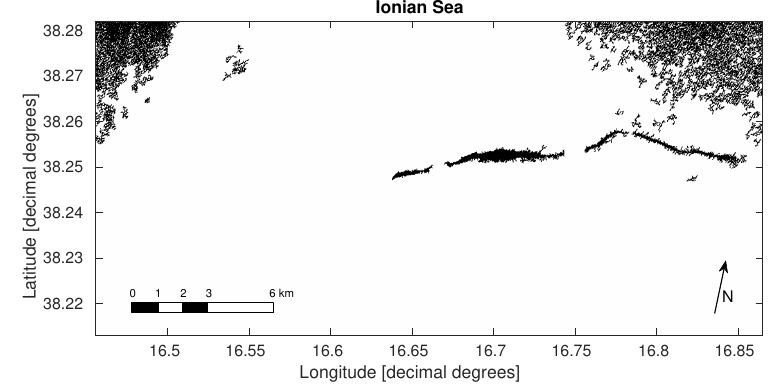
Figure 9. CSK StripMap HIMAGE of the Ionian Sea image after morphological processing (image not rotated into the Lat-Lon grid).